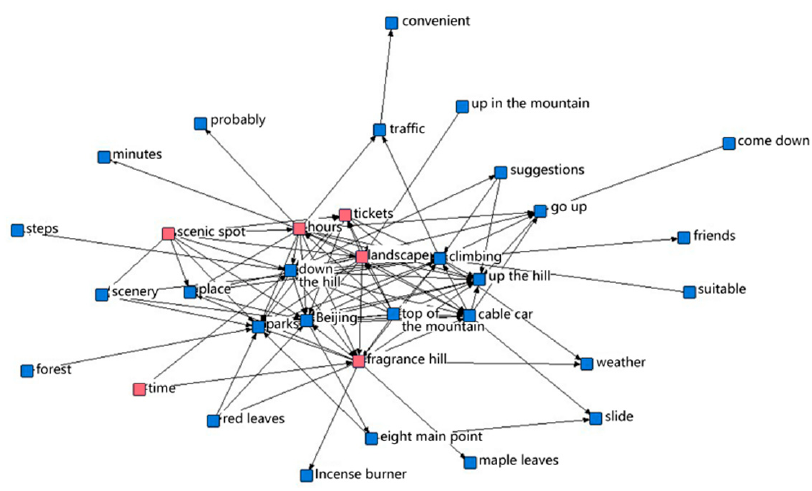
Figure 12. The semantic network of foreign tourists’ evaluations.